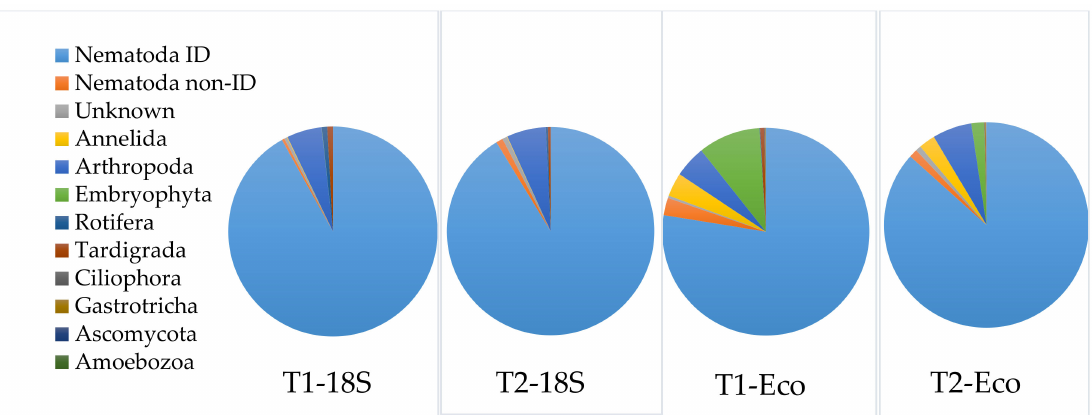
Figure 6. Mean of the relative abundance of sequence reads for samples T1 and T2 (Table 1) for each primer set (18S: NemFopt and 18Sr2bRopt primer set, Eco: EcoF and EcoR primer set) at phylum rank. Each color represents another phylum. Only the phylum Nematoda is further subdivided into a group that could be identified up to at least order level (Nematode ID) and a group that could not (Nematode non-ID). More details can be found in Supplementary File S4, tab